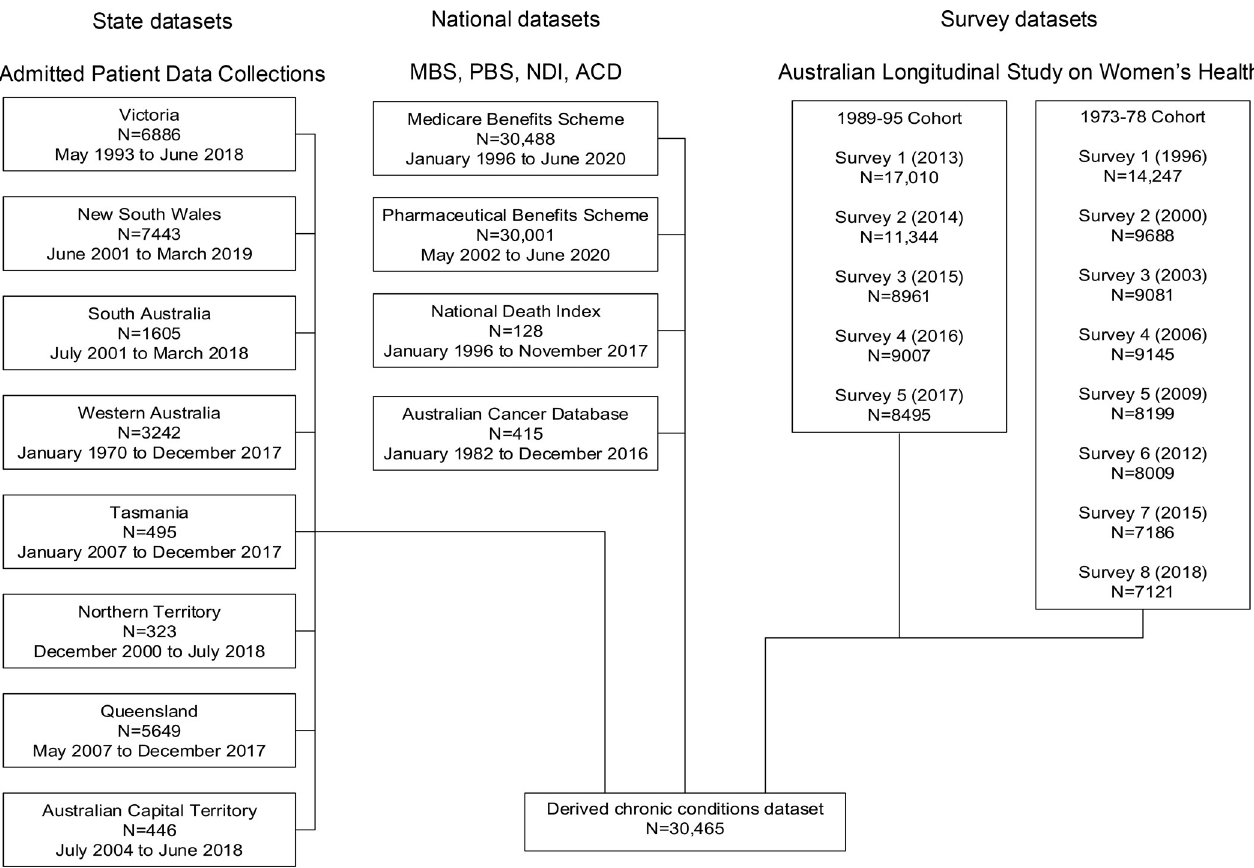
Fig 1. Relationships between data sources for case ascertainment of 10 key chronic